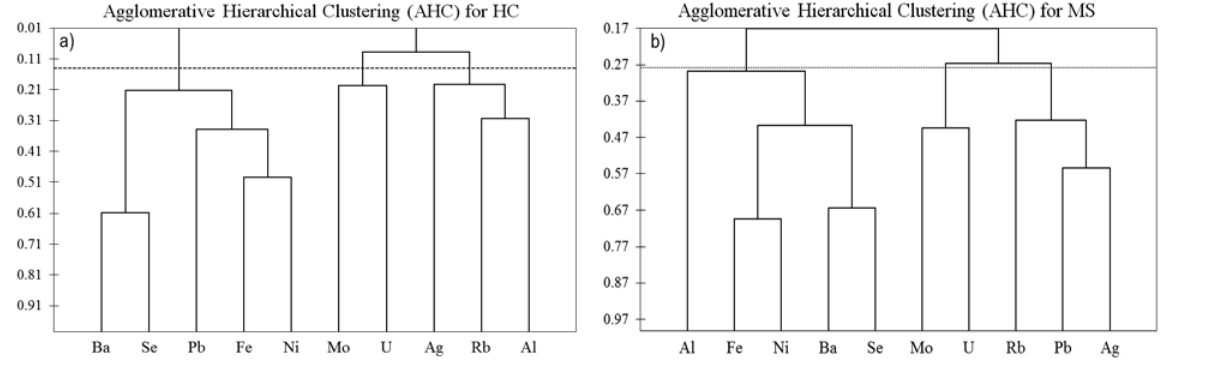
Fig 1. Agglomerative Hierarchical Clustering (AHC) performed using raw data. The degree of association is the Spearman ’ s